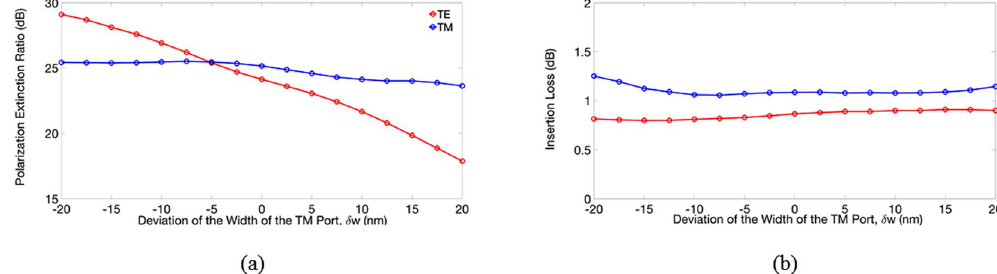
Figure 7. The calculated ( a ) PERs and ( b ) ILs of the TE and TM modes versus the deviation of the width of TM port, δ w .